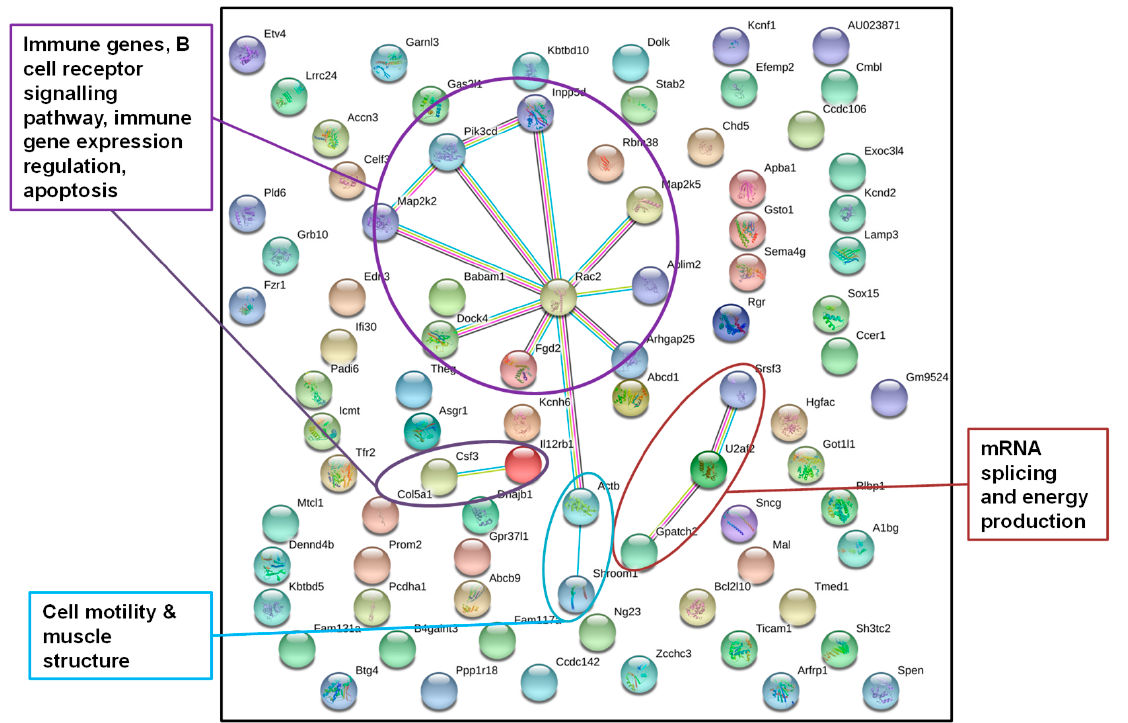
Figure 4. STRING gene network of genes from annotated DMRs in livers of F1 sons after paternal exposure to temperature increase; STRING gene network of genes from DMRs detected in the livers of at least four of the five father-sorted son groups after paternal exposure to increased temperature (“experiment H”). Gene network analysis identified genes encoding for proteins (dots) with a function in the immune system, cell structure, and RNA splicing (colors of dots were chosen by the STRING database and do not account for a certain gene function).